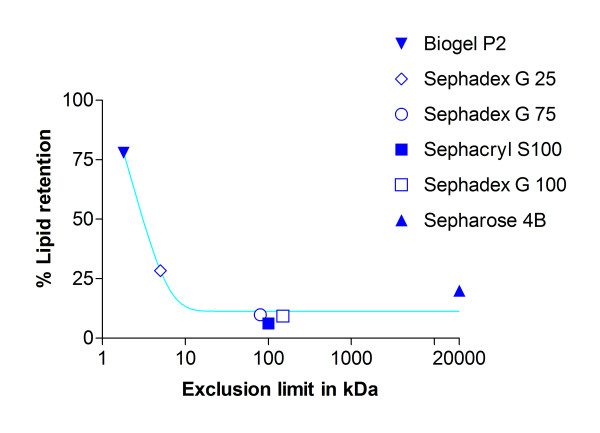
Liposome retention depends on bead pore size. Liposomes labeled with Rhod-PE were incubated with different gels and poured into columns. Fluorescence was collected before and after TX-100 addition to estimate the proportion of liposomes retained.